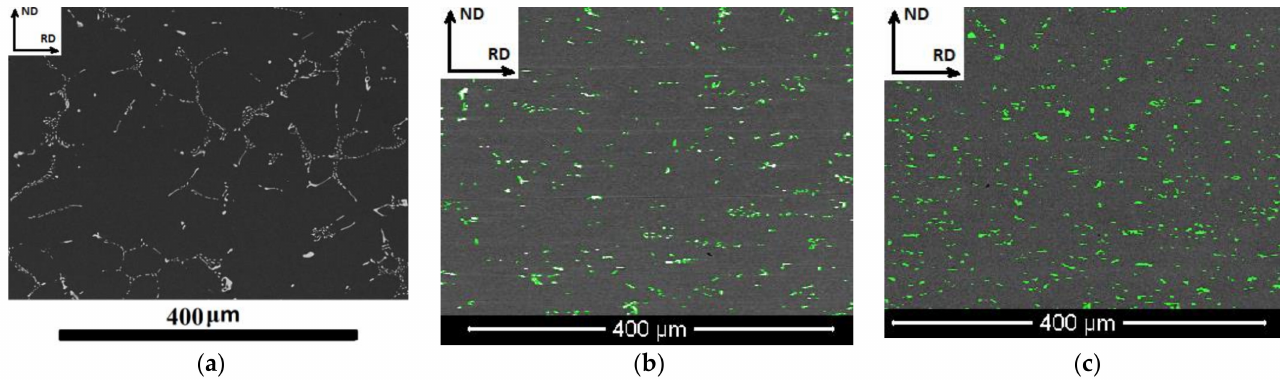
Figure 12. Micrographs of samples etched to reveal 8011 alloy phases: ( a ) 32.2% deformation, ( b ) 63.16% deformation, ( c ) 80.70% deformation µ